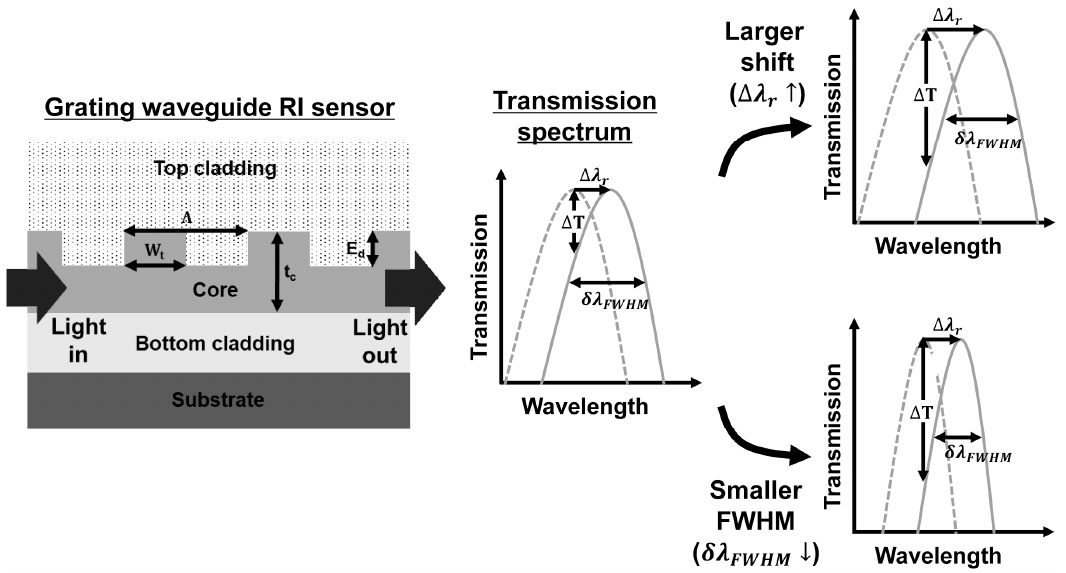
Figure 1. A grating waveguide refractive index (RI) sensor and its sensing principle. The figure set on right side depicts the dependence of transmission extinction ∆ T on a resonance wavelength shift (top right) and FWHM (bottom right); W t : width of tooth grating, Λ : grating period, t c : thickness of waveguide core, E d : etching depth, ∆ λ r : resonance wavelength shift, δλ FWHM : full-width at half-maximum, ∆T: transmission extinction.